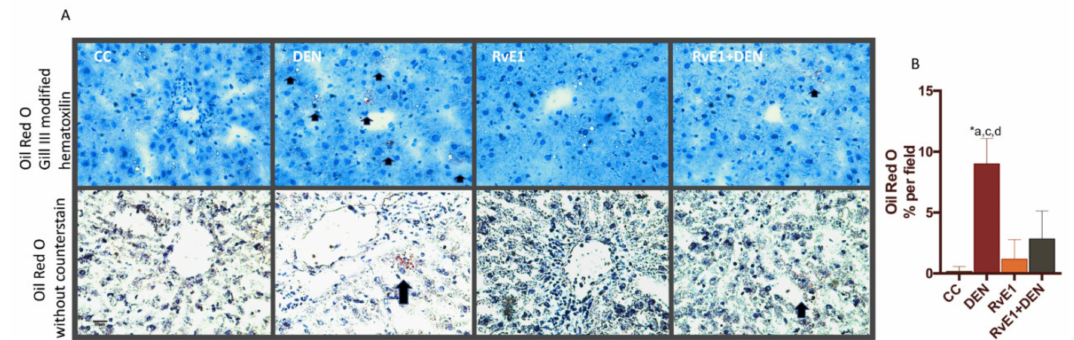
Figure 3. E ff ect of RvE1 on lipid deposit. ( A ) Representative histopathological microphotography of liver. Upper panel: Oil Red O plus counterstain Gill III modified hematoxylin. Lower Panel: Oil Red O without counterstain. ( B ) Quantification of Oil Red O percentage per field. Magnification 400 × . At least 20 fields for every sample were analyzed. n = 6 animals per experimental group. Asterisk indicates p < 0.05, and the letters identify the experiments that are compared and present this statistical di ff erence. Arrow indicates the high areas of Oil Red O